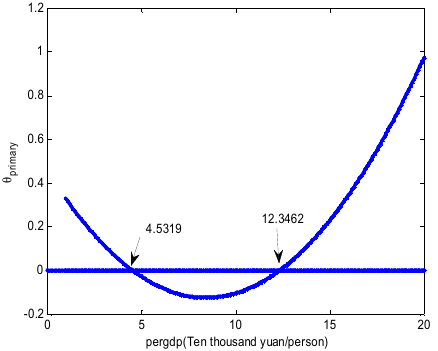
Figure 4. The instantaneous indirect effect of pergdp on COD Mn concentration through primary.